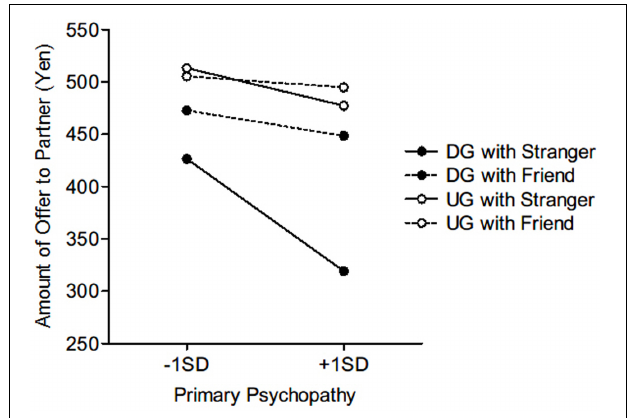
FIGURE 1 | Effect of primary psychopathy on monetary offers (for a total amount of 1000 yen) in the dictator game (DG) and the ultimatum game (UG) with strangers and